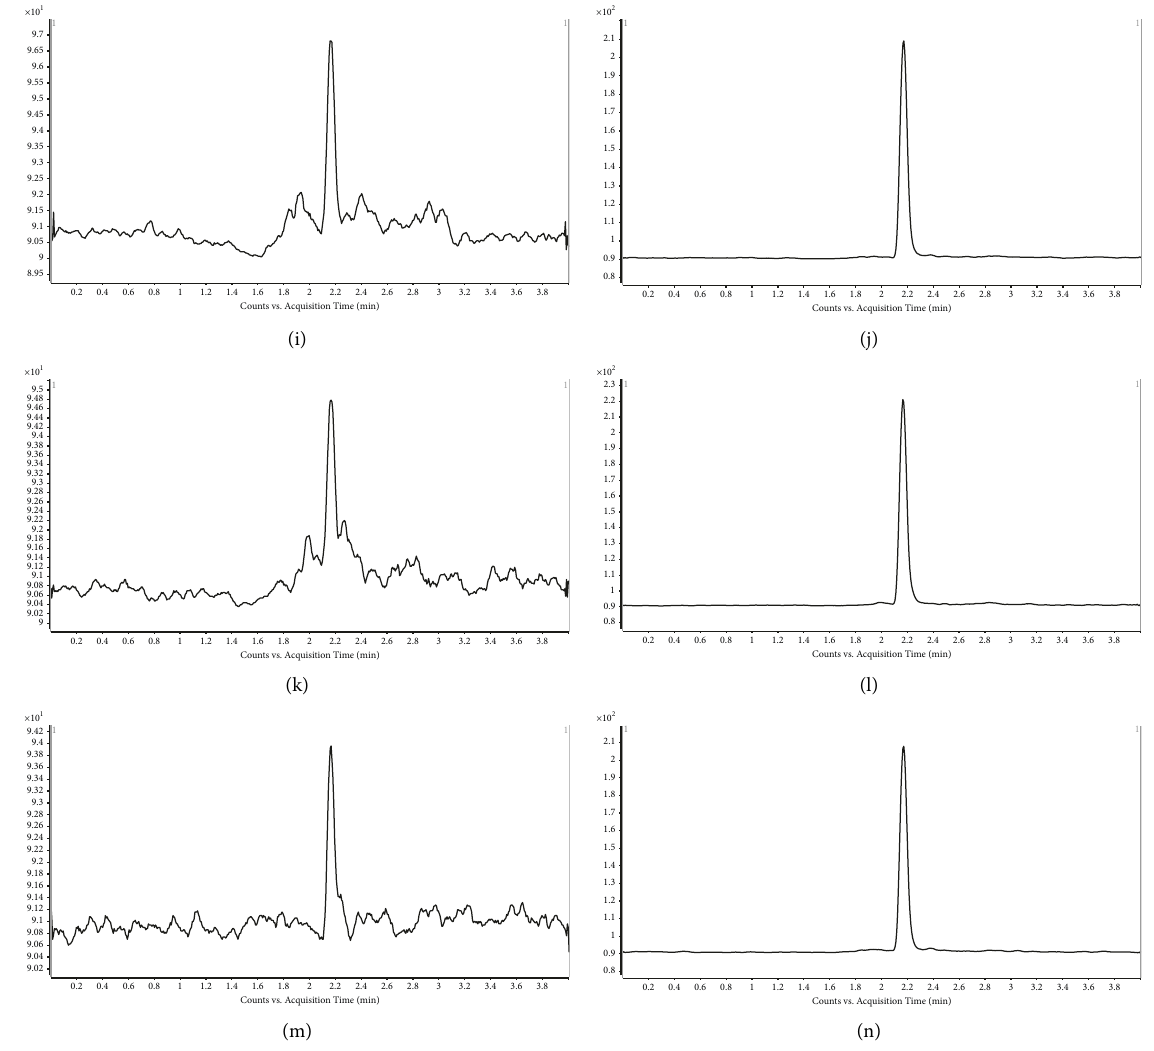
Figure 2: LC-MS/MS chromatograms of (a) acetonitrile solvent, (b) blank rapeseed sample, (c) phthalanilic acid standard solution (0.01mg L − 1 ), (d) spiked rapeseeds sample (0.02 mg kg − 1 ), (e) blank wheat grains sample, (f) spiked wheat grains sample (0.01mg kg − 1 ), (g) blank wheat straw sample, (h) spiked wheat straw sample (0.05 mg kg − 1 ), (i) blank corn sample, (j) spiked corn sample (0.01 mg kg − 1 ), (k) blank rice sample, (l) spiked rice sample (0.01mg kg − 1 ), (m) blank millet sample, and (n) spiked millet sample (0.01mg kg − 1